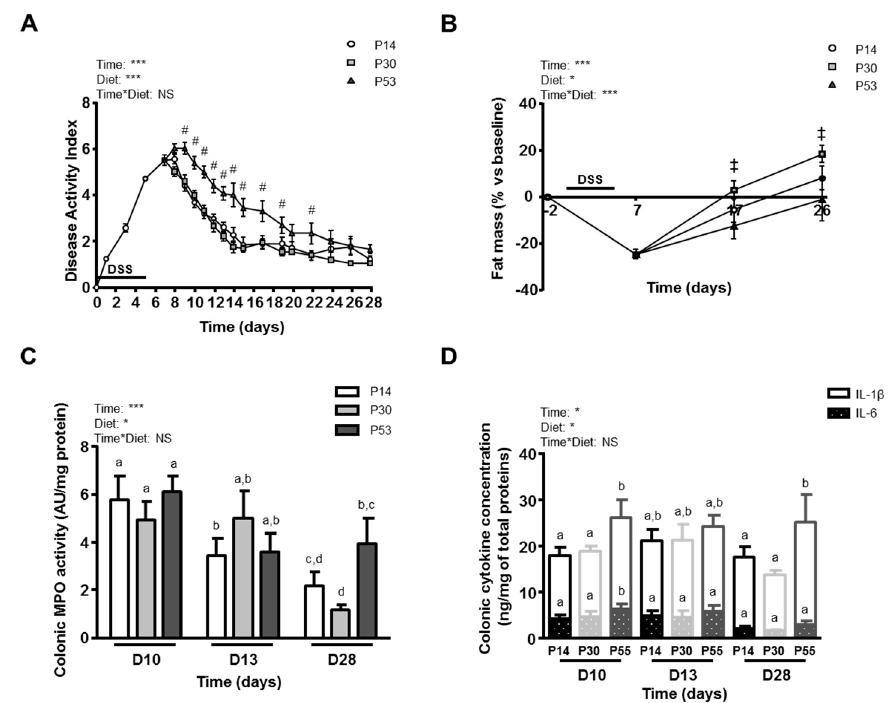
Figure 2. Effects of dietary protein intake level on inflammatory parameters at after 3 (D10), 6 (D13) or 21 days (D28) of dietary intervention with P14, P30 or P53 diet. ( A ): Disease activity index scoring evolution during time. #: p < 0.05 DSS P53 vs P14 and P30 at the same time point. ( B ): Evolution of fat mass (percentage vs baseline). ‡: p < 0.05 DSS P53 vs P30 at the same time point. ( C ): Colonic MPO activity. ( D ): Colonic concentrations of the pro-inflammatory cytokines IL-6 and IL-1 β . Values are means ± SEM ( n = 9–12). Means that are significantly different ( p < 0.05) according to the post-hoc test have different letters (a or b or c or d). *: p < 0.05; ***: p < 0.001; NS: non-significant difference.